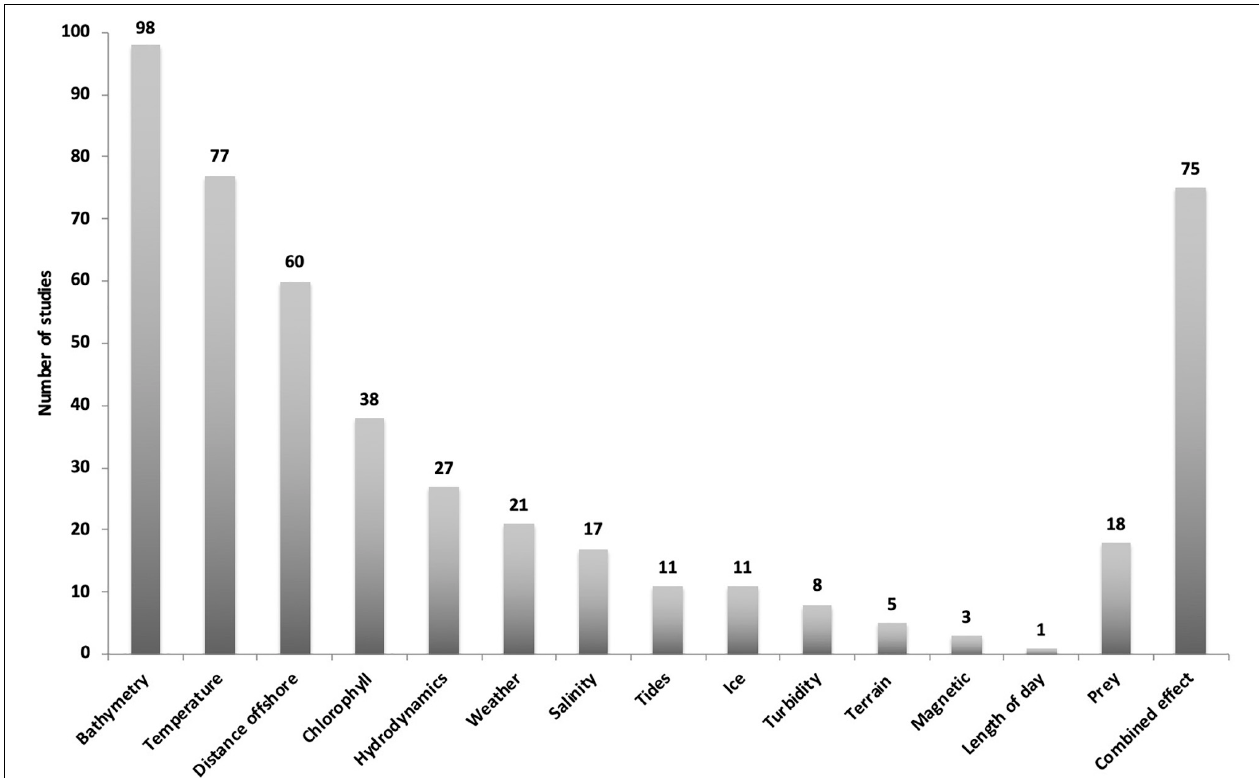
FIGURE 5 | Overview of environmental driver categories from 148 publications investigating humpback whales and relationships with environmental drivers. Most studies tested more than one variable with 75 studies testing combined